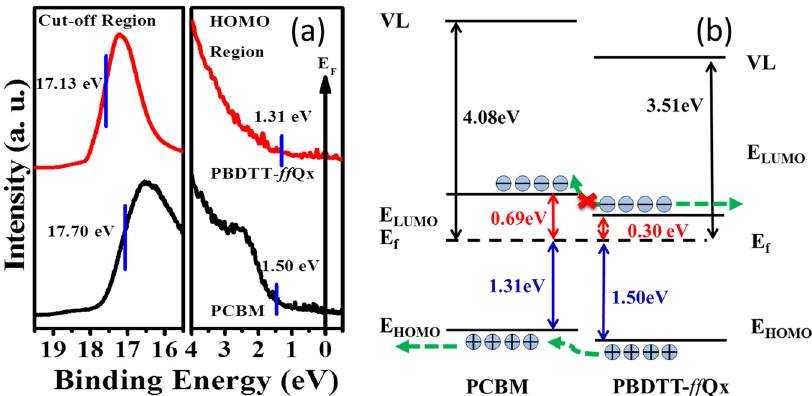
Fig. 7 a UPS spectra of cut-off region and HOMO region in PBDTT- ff Qx and PCBM thin fi lms. b Schematic energy levels of the PBDTT- ff Qx and PCBM thin fi